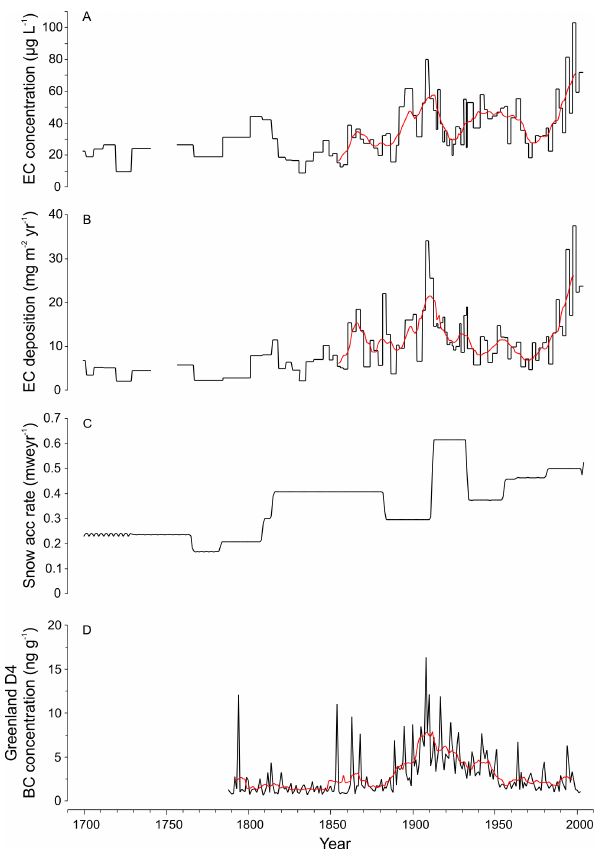
Figure 3. EC concentration and deposition compared to the snow accumulation rate in the Holtedahlfonna ice core, and BC con- centrations in the Greenland D4 ice core (McConnell et al., 2007). (a) EC concentration (µgL − 1 ) and (b) EC deposition (mgm − 2 yr − 1 ) with 10-year running averages (red). (c) Snow accu- mulation rate (mw . e . yr − 1 ) of Holtedahlfonna. Note that the snow accumulation rate incorporates all processes increasing (precipita- tion) and decreasing (ablation and runoff) it. (d) Annual BC con- centration (ngg − 1 ) data (black) from the Greenland D4 ice core (McConnell et al., 2007) with 10-year running averages